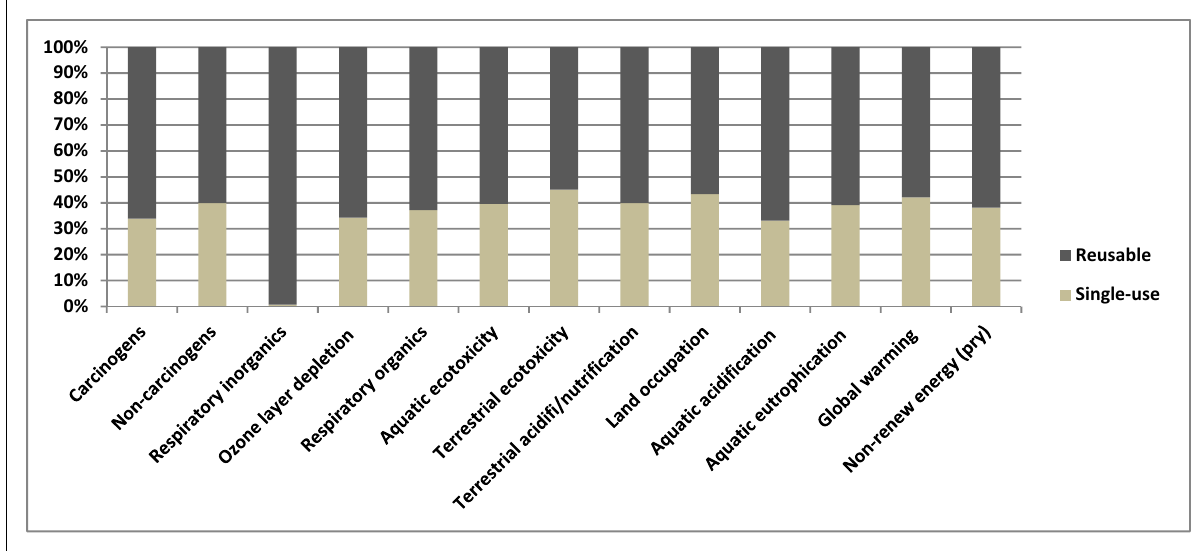
Figure 4: Better performance in impacts of a single-use PET bottle at mass ratio of 0.45. Environmental impacts avoided by the recycling rate